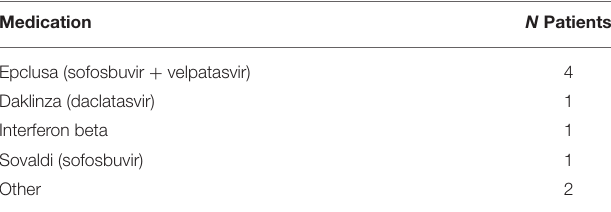
TABLE 5 | Treatment of HCV + patients based on patient-level prescription data (China DOPPS, 2019–2021). Medication N Patients Epclusa (sofosbuvir + velpatasvir)